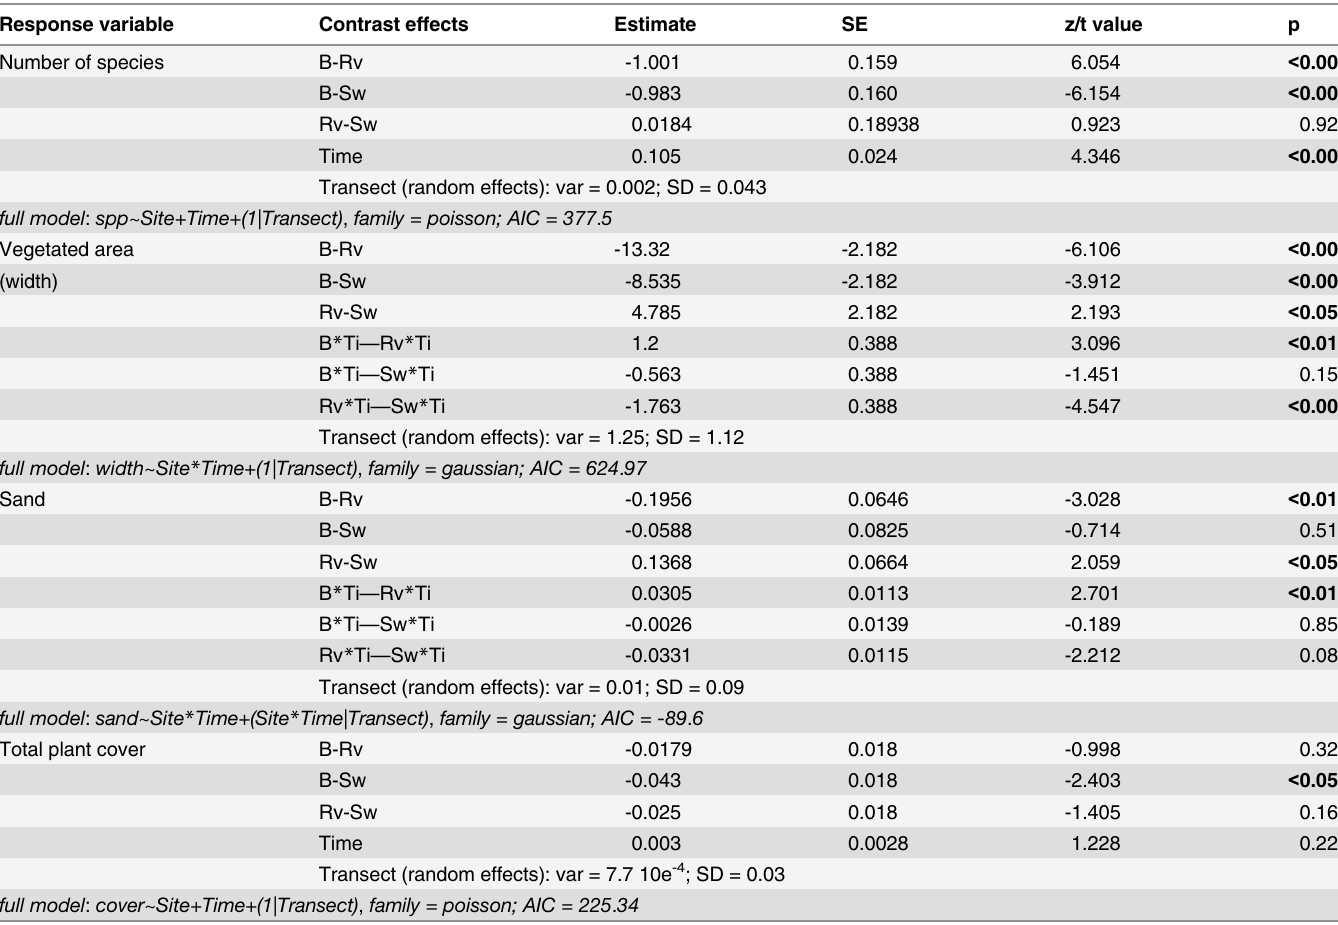
Table 1. Results of GLMMs (model fit by maximum likelihood, Laplace approximation) containing pair-wise contrasts for the main response vari- ables of the vegetated area at each study site. Response